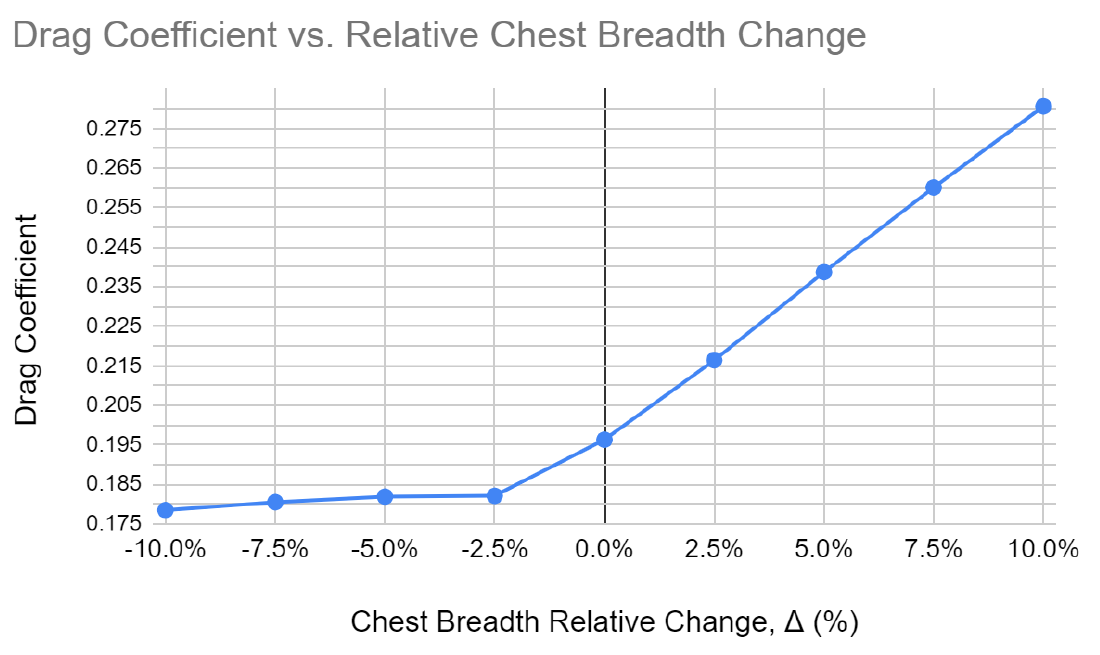
Figure 14. Graph of Relative Chest Breadth Change (top view model) vs. Drag Coefficient.